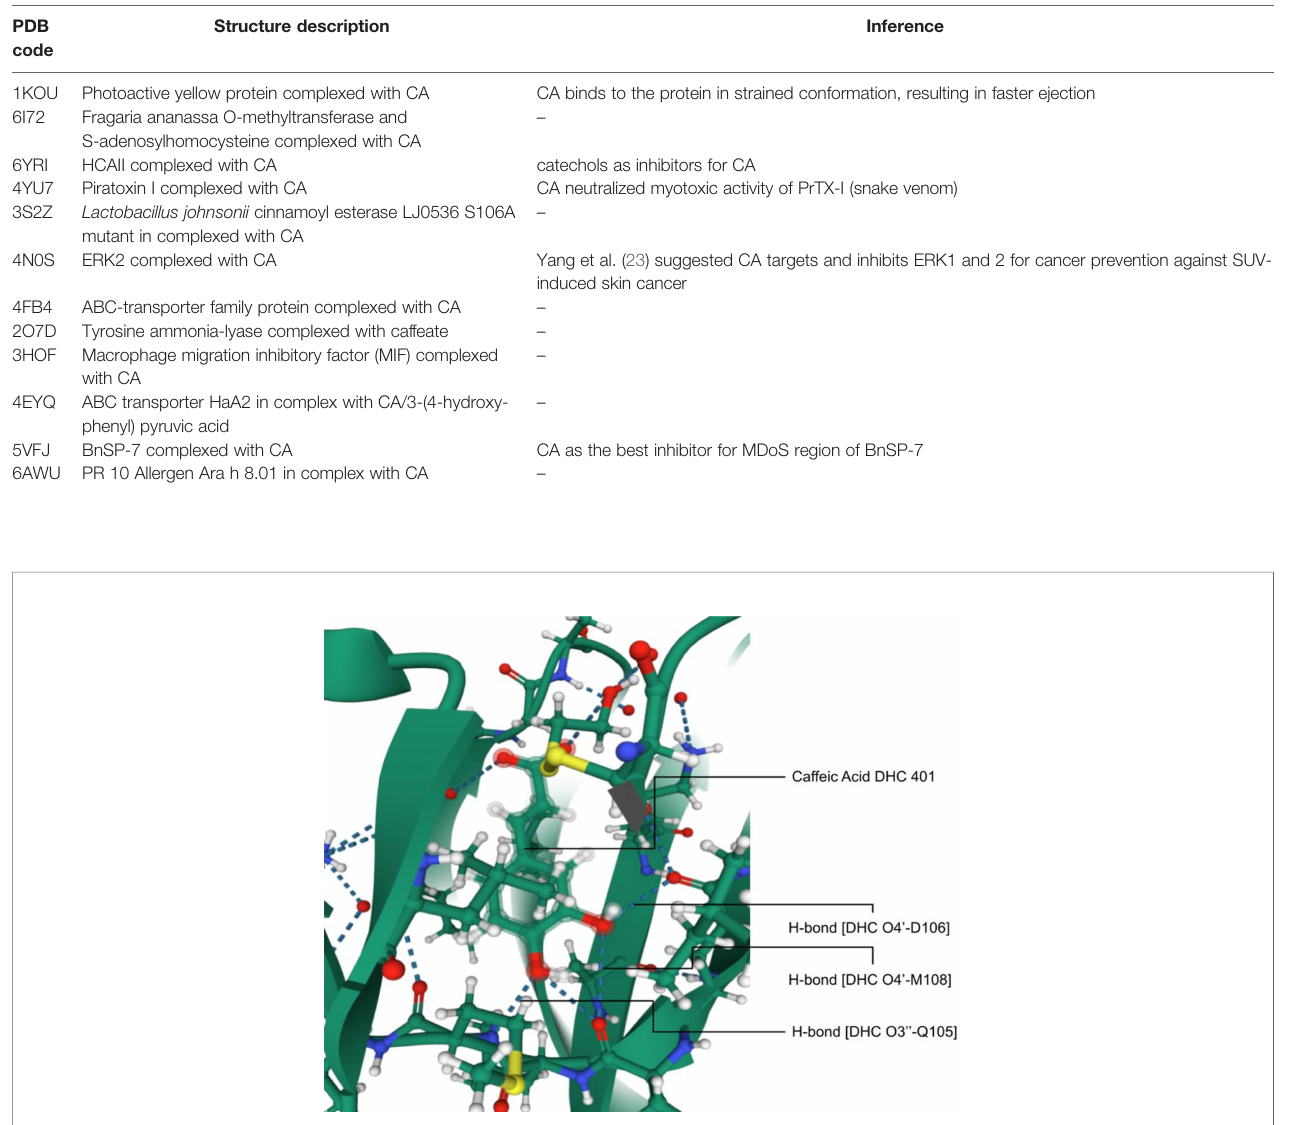
FIGURE 3 | Interaction of ERK2 with caffeic acid; hydrogen bonding between DHC O4 ’ -D106, M108, and CA O3 ’ -Q105 imparting molecular level inhibition of the protein [Adapted from Yang et al.